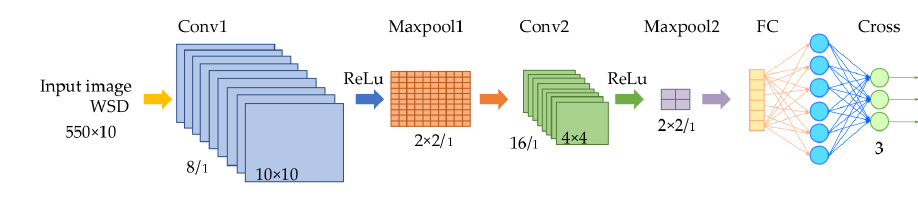
Figure 7. Proposed CNN